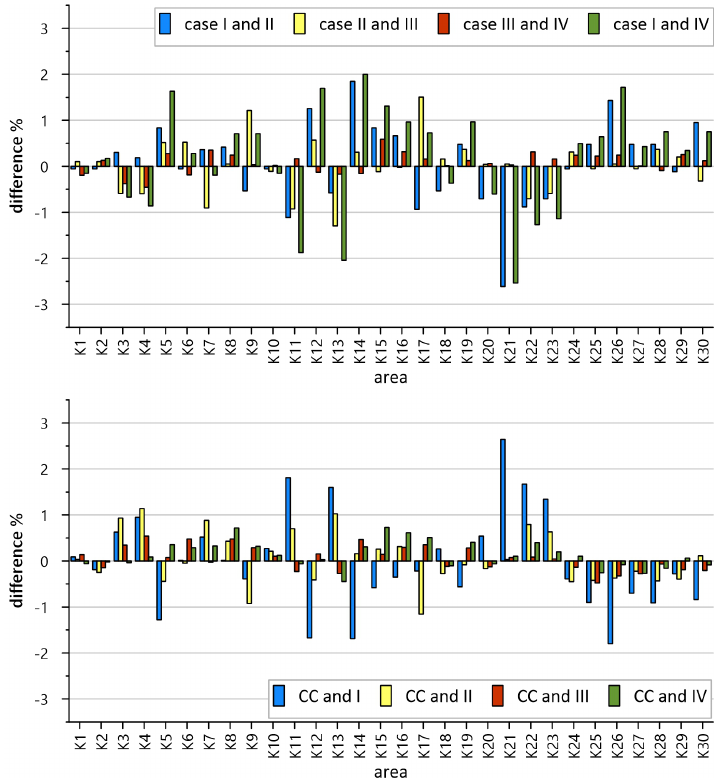
Figure 11. Difference in area (%) between individual measurement cases (CC, computer calculation).